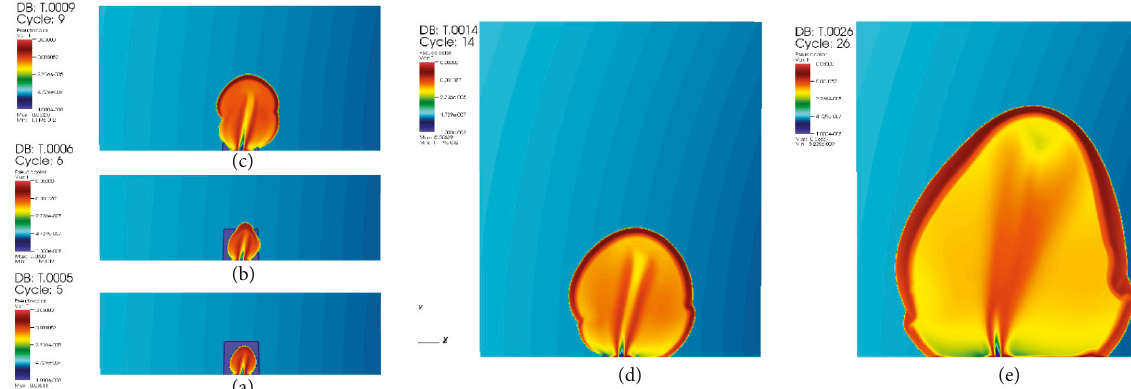
Figure 3: Scenario C: a series of slices representing the time evolution of temperature, as in scenario A of [13], but now assuming increased precession rate (see text). The temperature image depicts 2D slices cut along the jet, at a specific time instant. The precessing jet can be seen (d,e) to sweep across a larger (compared to scenario A [13]) portion of the surrounding wind volume, piling up additional matter around its head and sides (see run3 parameters in Table 1). The expansion rateis lower in the accretion disk wind region and increases in the stellar wind region, but afterwards it stays relatively constant, as the density gradient of the wind (visible in the images) is not too large along the jet path.